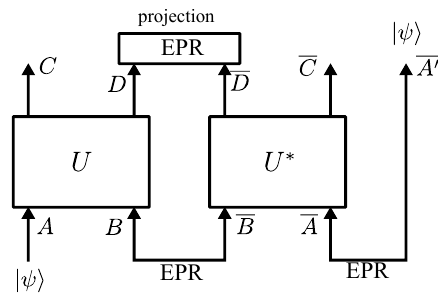
Figure 5 . A recovery protocol for the Hayden-Preskill thought experiment from [31]. The input quantum state on A is teleported to A 0 upon postselecting DD to be EPR pairs. In the diagram, j i A = A = A 0 , B = B , C = C , and D = D . Here DD are interpreted as outgoing j j j j j j j j j j j j j j j j j j